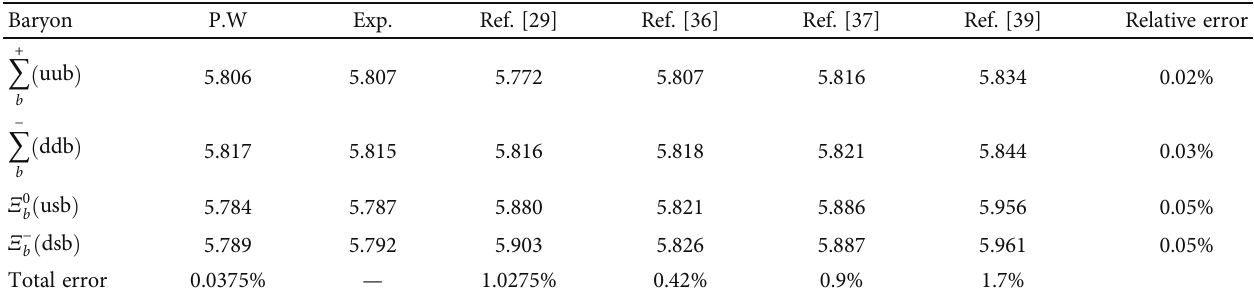
The energy eigenvalue for the mode ν = 0 and grand